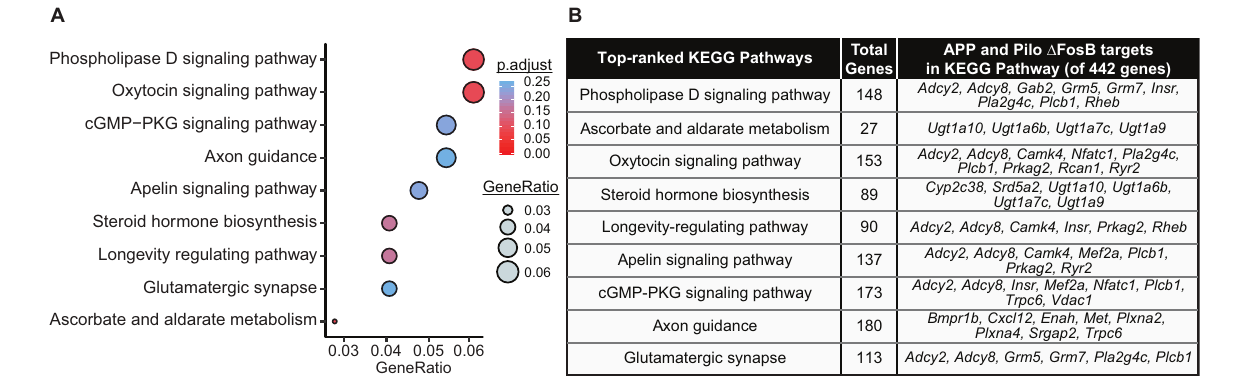
with recurrent seizures (Corbett et al., 2017; You et al., 2017).